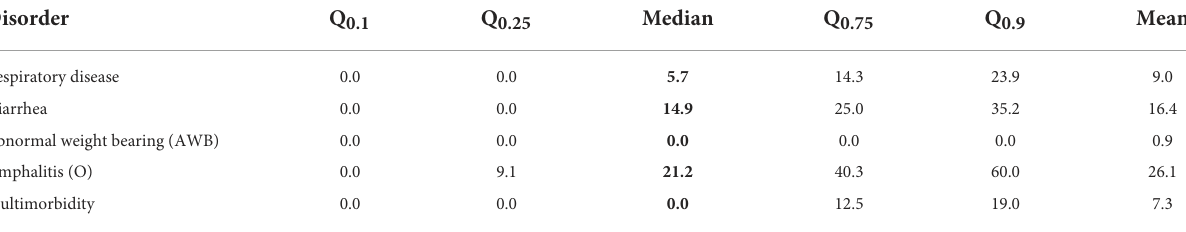
TABLE 8C Herd prevalence of disorders in pre-weaned dairy calves on 180 farms with 61–120 dairy cows * . Disorder Q 0.1 Q 0.25 Respiratory disease Diarrhea Abnormal weight bearing (AWB)